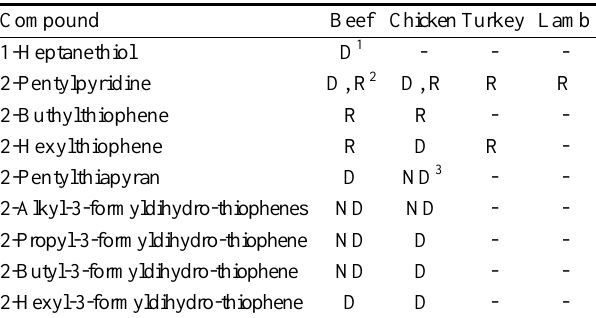
Table 4. Selected lipid-Maillard product in cooked meat (adapted from Melton, 1999) Compound